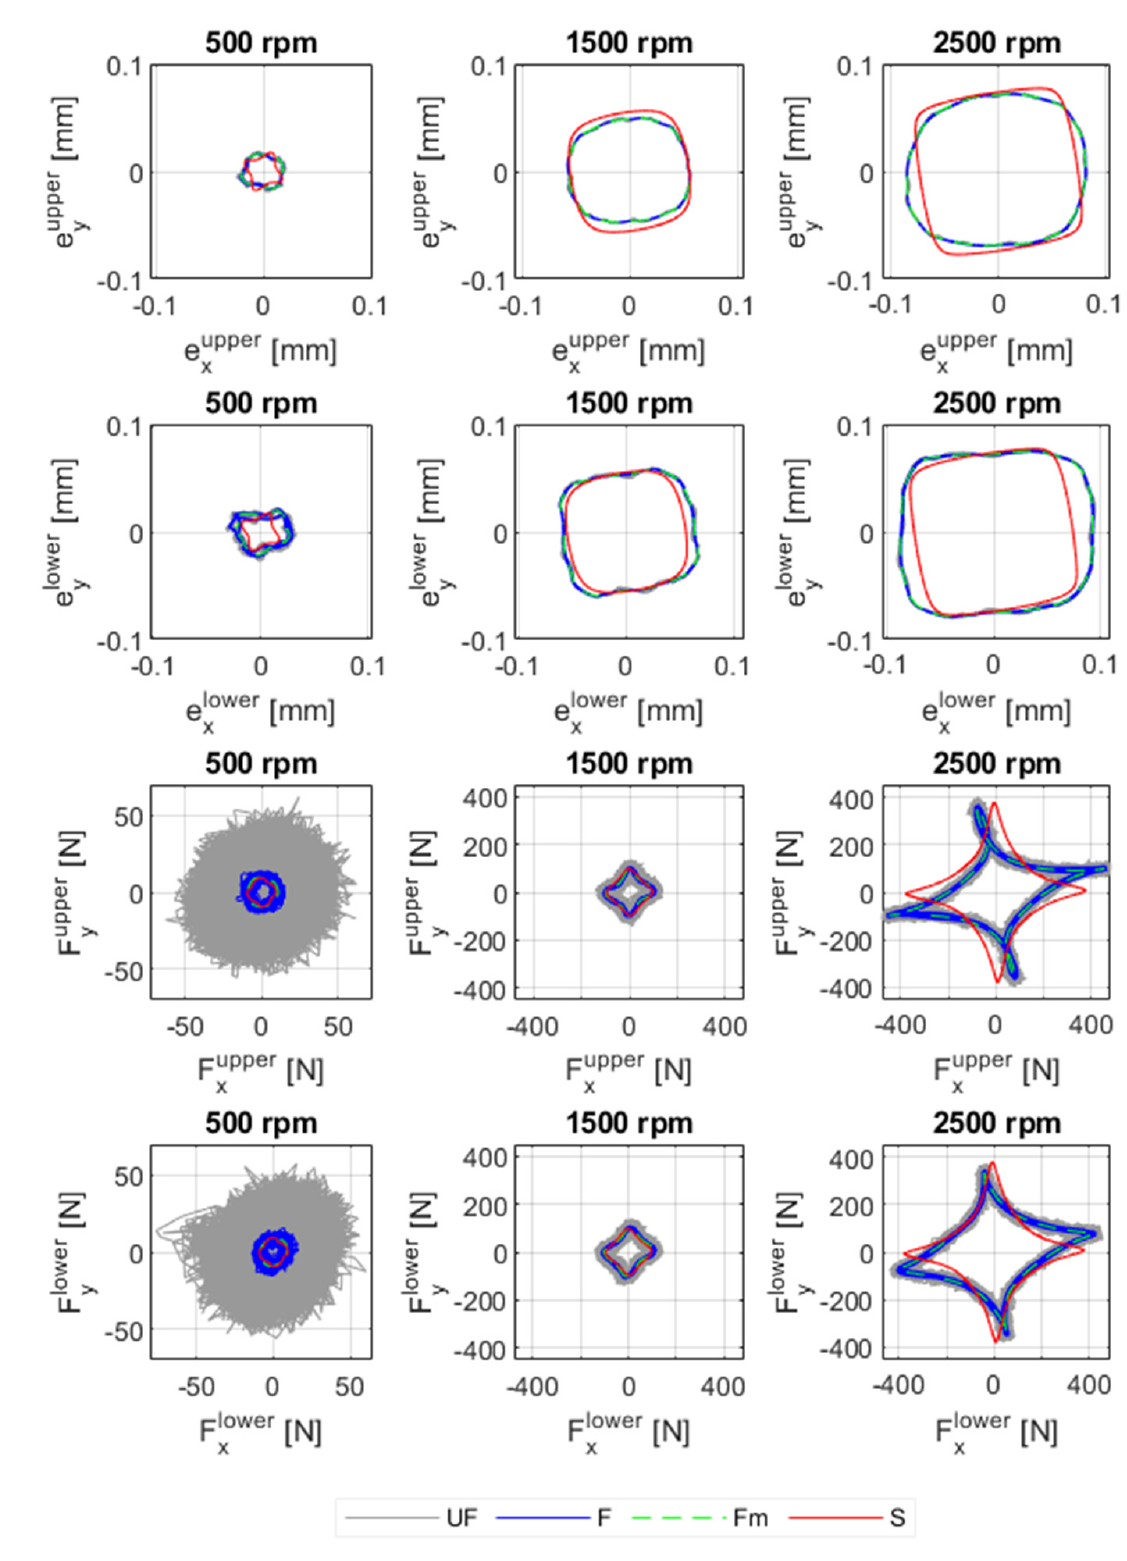
Figure 12. Orbits and bearing forces for the upper and lower bearings with 5.9 × 10 − 3 kg·m unbalance magnitude and at 500 rpm, 1500 rpm and 2500 rpm: UF: unfiltered measurement signal; F: filtered measurement signal by a band pass filter; Fm: the average value of the filtered measurement signal; S: simulation.